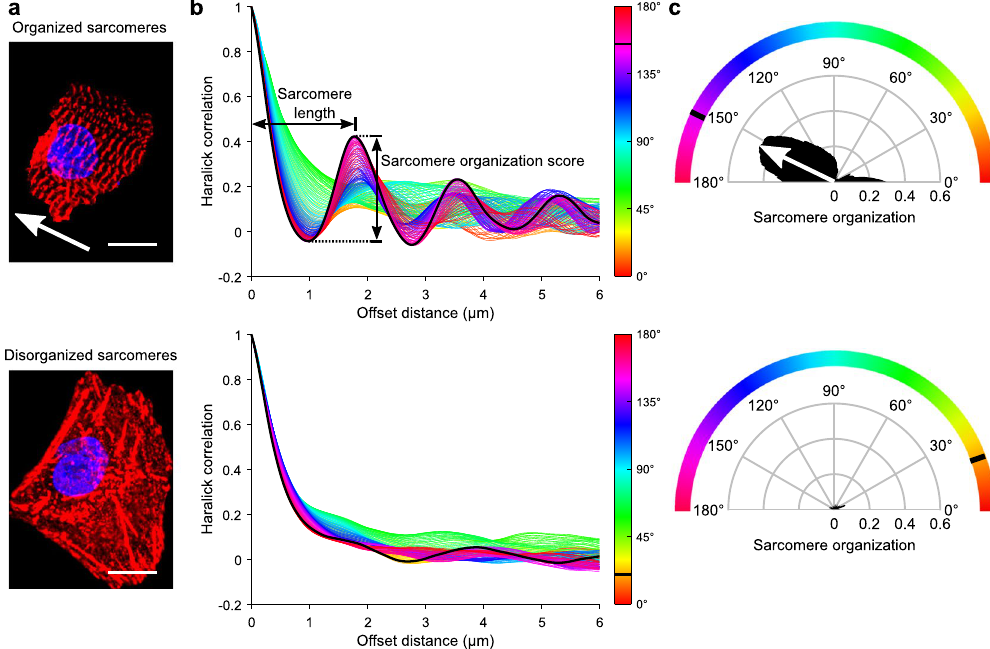
Figure 4. Automated measures of sarcomere organization and sarcomere length. ( a ) Masked immunofluorescence images of neonatal mouse CMs with organized (top) or disorganized (bottom) sarcomeres. Scale bar = 10 μ m. ( b ) Haralick correlation metric computed at multiple offset distances and angles to determine sarcomere organization and sarcomere length. Sarcomere organization score is the maximum amplitude of the decaying sinusoidal trace. Sarcomere length is the distance to the first peak. ( c ) Sarcomere organization assessed as a function of angle to assess the primary direction of sarcomere alignment. Arrow points in the direction of sarcomere alignment and is repeated in ( a ). Color bar in middle panel aligns with circumferential color bar in right panel.